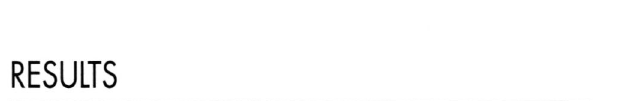
characters were examined for the purposes of taxo- nomic identification, using 40x and lOOx